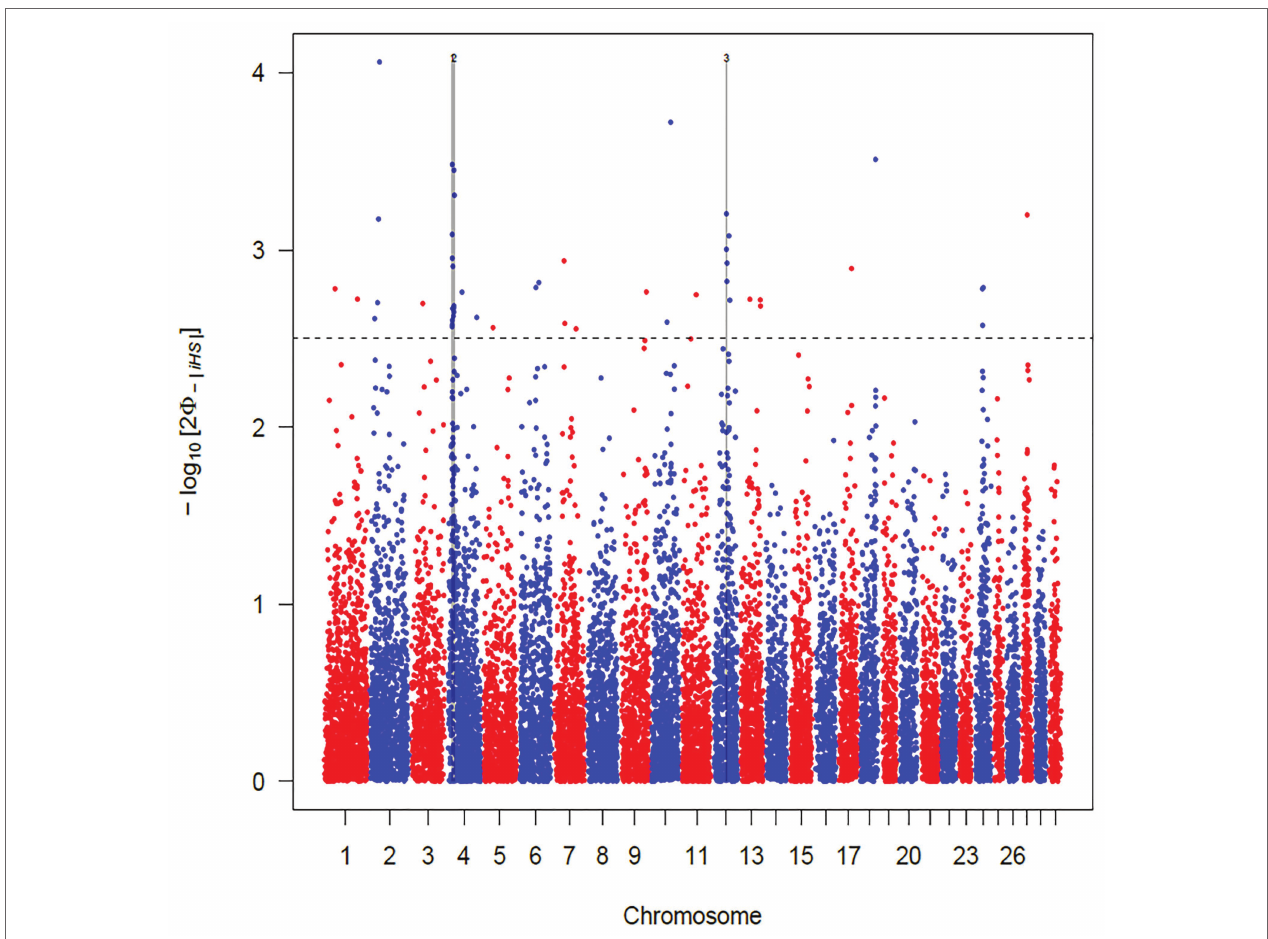
FIGURE 3 | Manhattan plot of the genome-wide integrated haplotype score ( iHS ) analysis for Maremmana breed. Horizontal dashed line mark the significance threshold applied to detect the outlier single nucleotide polymorphisms (SNPs) − log10 ( p -value) =